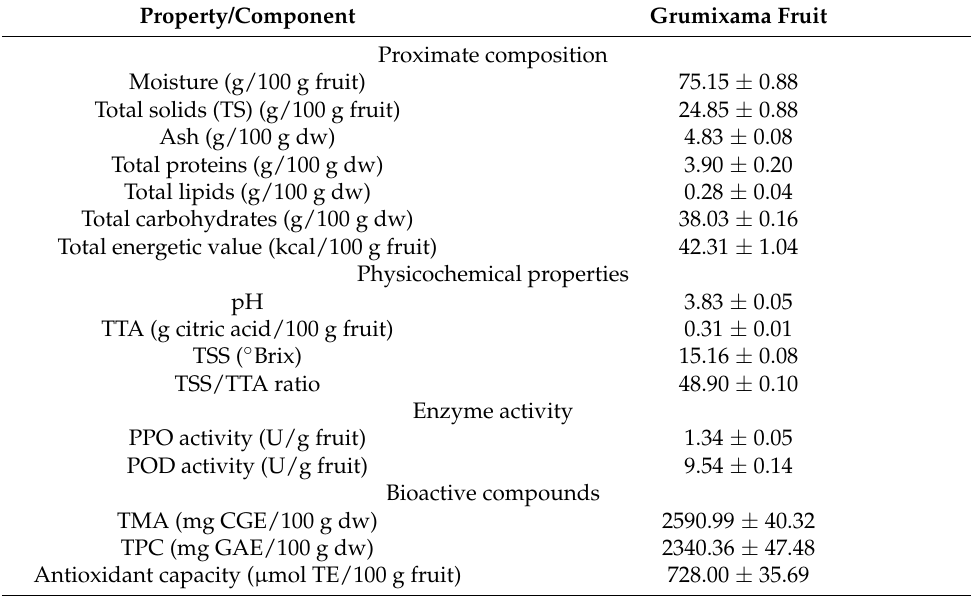
Table 1. Proximate composition, physicochemical properties and enzyme activity of grumixama fruit ( Eugenia brasiliensis Lam).